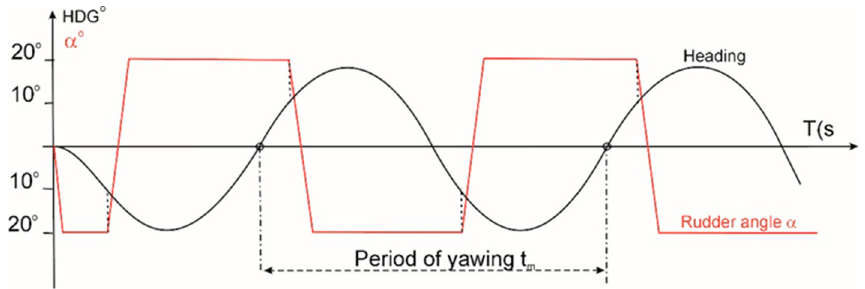
Figure 1. The zig-zag test (20-10 variant). Based on the data obtained from this test, the dimensionless directional stability coefficient is calculated.